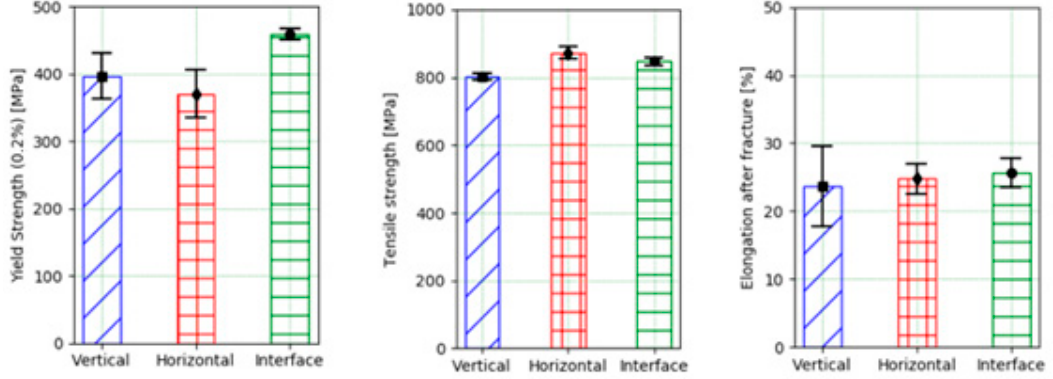
Figure 9. Mechanical properties of the LMD wall. Table 3. Chemical composition of the powder material and the LMD-AD material.